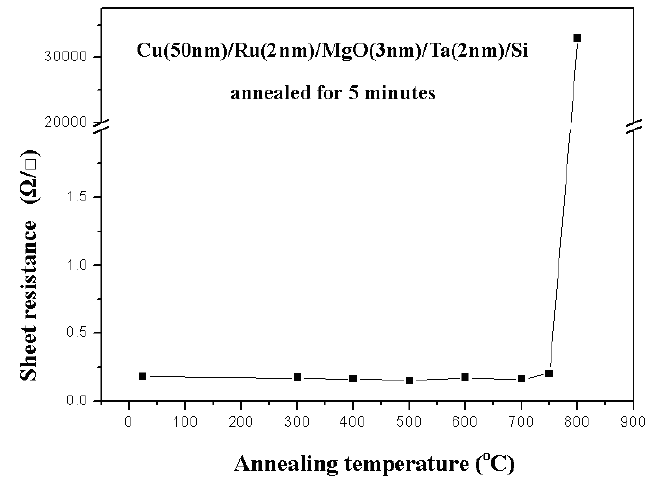
Figure 1. Relation between sheet resistances and annealing temperatures for Cu (50 nm)/Ru (2 nm)/MgO (3 nm)/Ta (2 nm)/Si structure annealed for 5